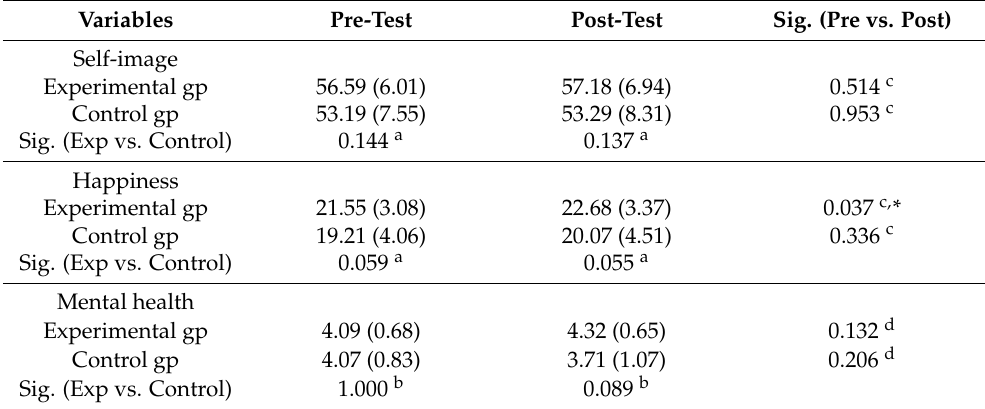
Table 2. Comparison of pre- and post-test between experimental and control groups and the change after intervention for the two groups.